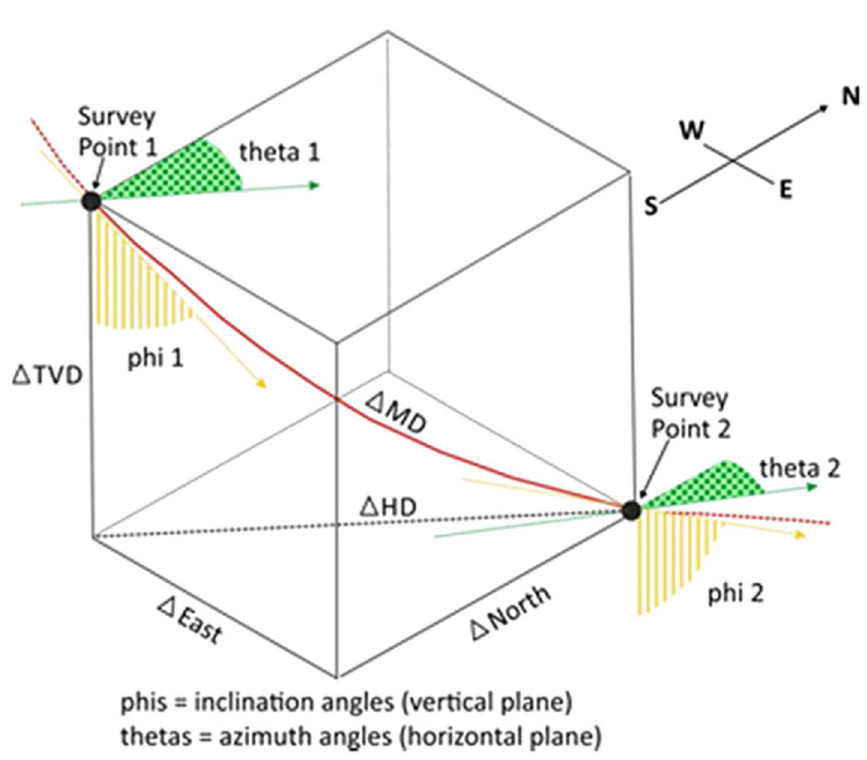
Fig. 1 Calculation of the length for a deviated section of the well trajectory after Atash- nezhad et al. (2014) describes the terms used to define the different angles and compo- nents of the wellbore trajec- tory. MD = measured depth; TVD = true vertical